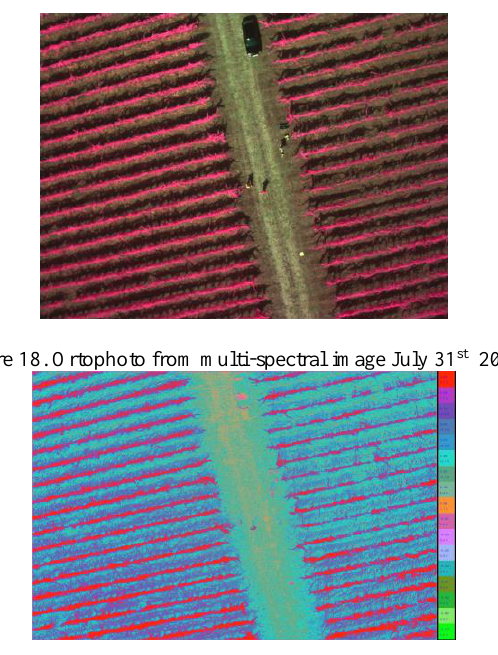
Figure 19. Ortophoto with NDVI values July 31 st 2017